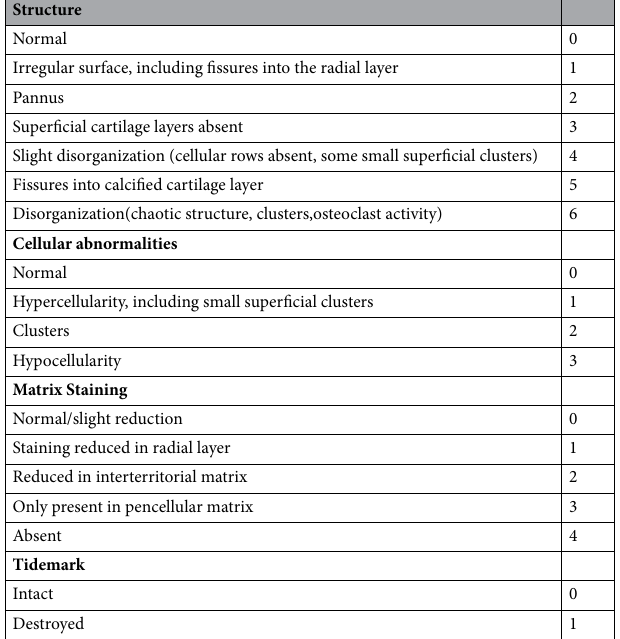
Table 2. Modified Mankin Score for